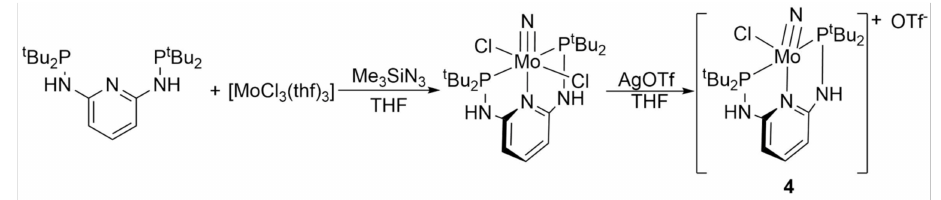
Run Catalyst NH 3